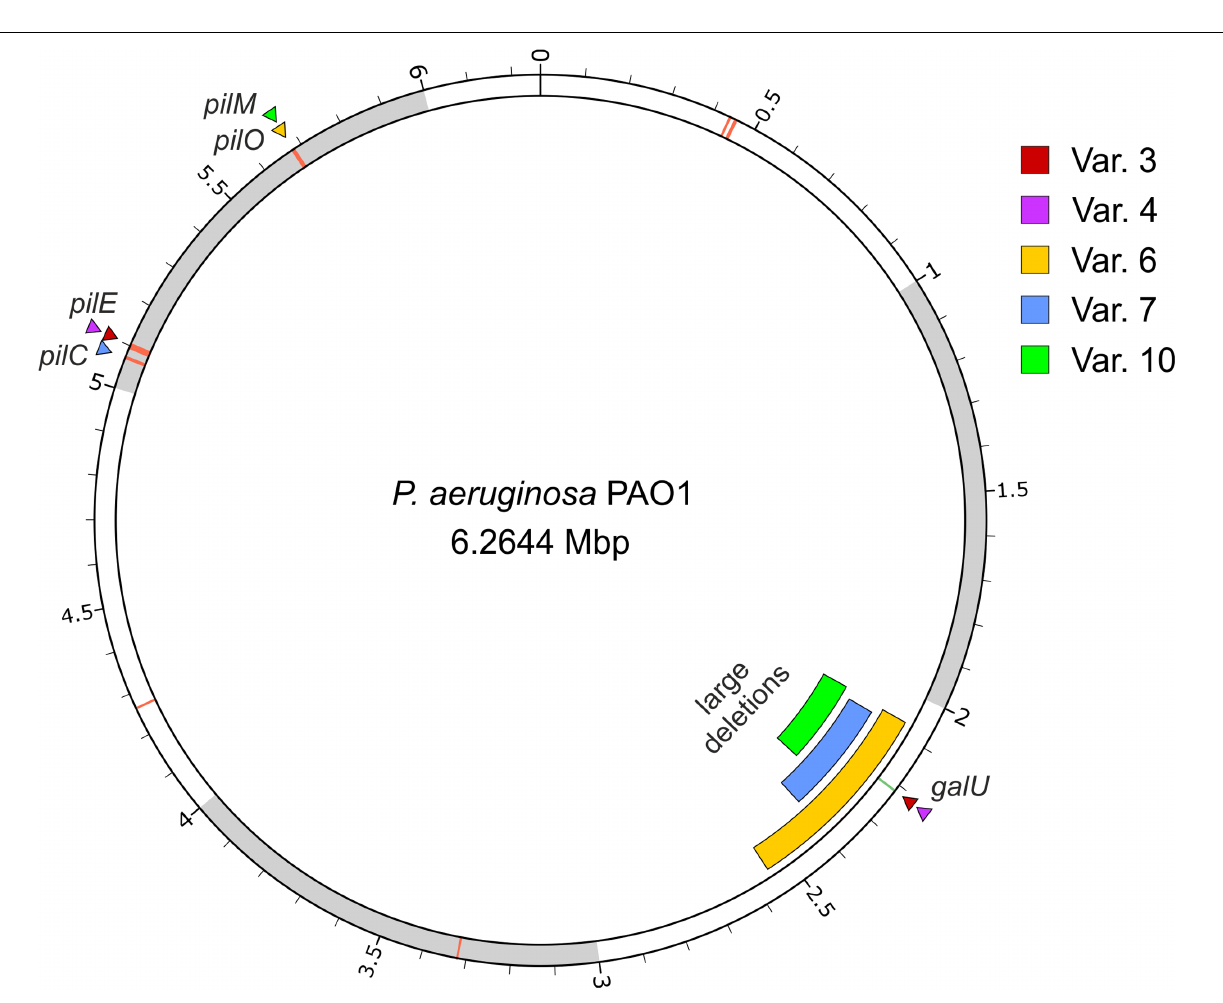
FIGURE 3 | Location of the genomic variations of five phage-resistant strains derived from P. aeruginosa . The image displays the PAO1 wild-type chromosome with variant loci indicated by triangles (single nucleotide variants) or bars (large deletions). The location of the pil genes are additionally marked by red lines on the chromosome. The image was created using circos (Krzywinski et al.,